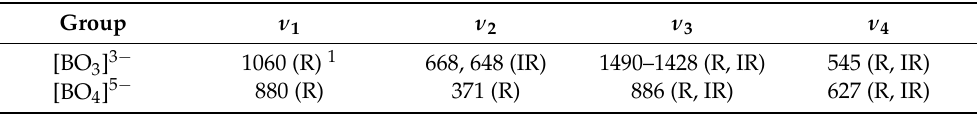
Table 1. Vibrational frequencies for the normal modes of isolated planar BO 3 ( D 3h ) and tetrahedral BO 4 ( T d ) groups in crystalline state [33] . All of the frequencies are in cm − 1 .